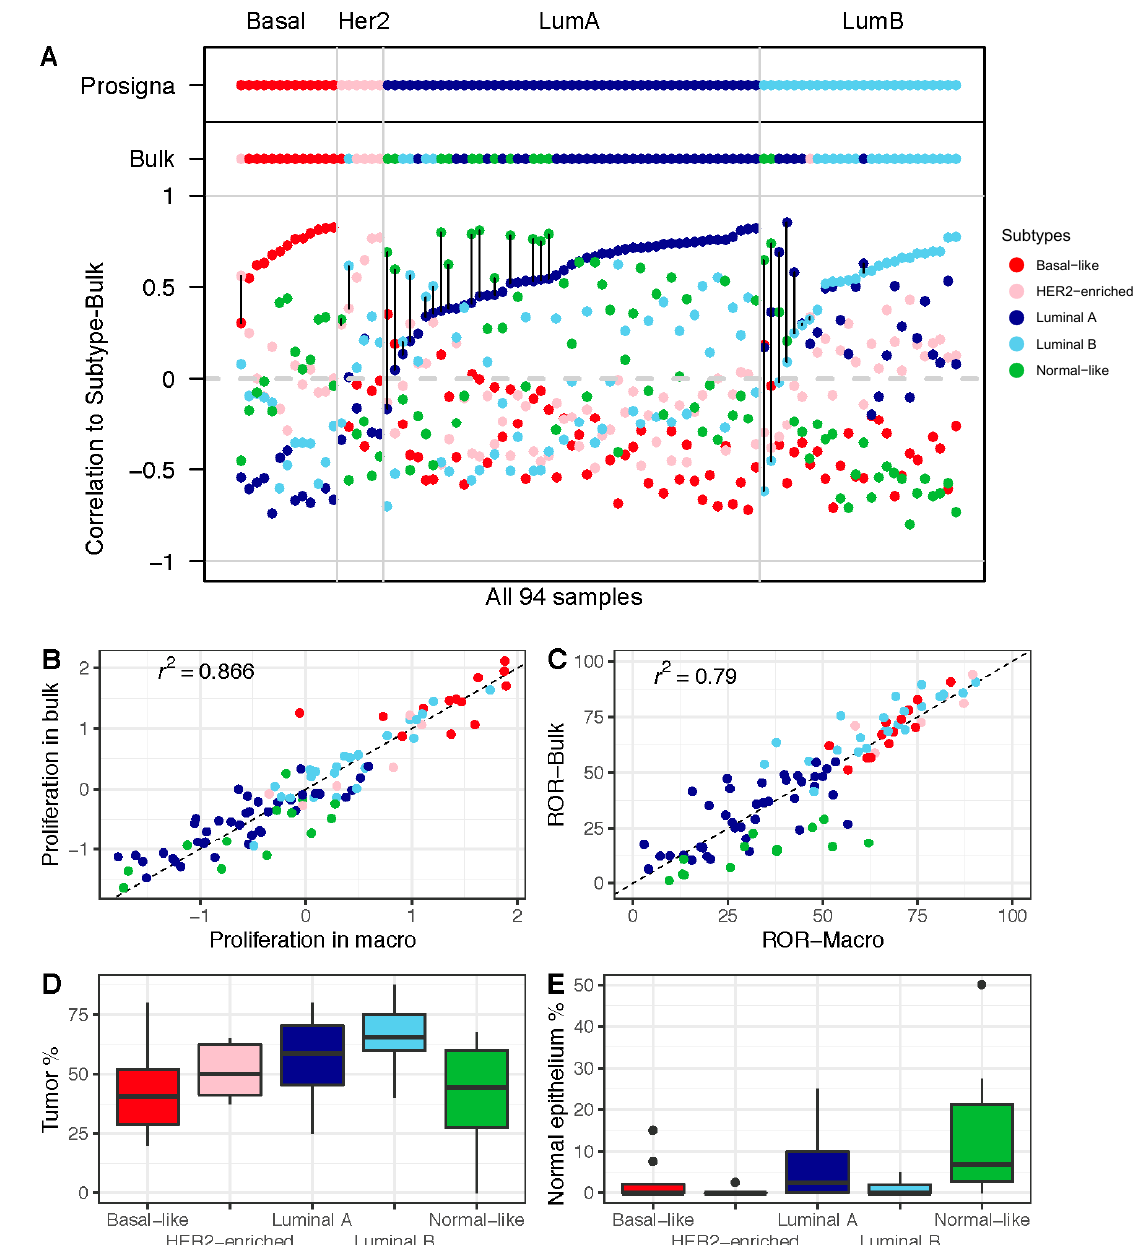
Figure 3. Impact of gene expression in FF bulk tumor tissue on subtype calls and ROR: ( A ) Correlation with each of the five PAM50 subtype centroids, calculated based on the research-based Subtype-Bulk from FF tumor tissue. PAM50 calls from Subtype-Prosigna and Subtype-Bulk are shown on top for comparison. Correlation coefficients on the y -axis, and the 94 breast tumor samples along the x -axis, are sorted by increasing correlation with Subtype-Prosigna. Discordant cases between Subtype-Prosigna and Subtype-Bulk are marked with black vertical lines. Samples are colored according to subtype (red = basal-like; pink = HER2-enriched; dark blue = luminal A; light blue = luminal B; green = normal-like). ( B ) Proliferation score from macrodissected FFPE plotted against FF bulk tumor tissue. ( C ) ROR-Macro plotted against ROR-Bulk. ( D ) Boxplots showing estimated tumor content across subtypes. ( E ) Boxplots showing estimated normal breast epithelium across subtypes. In panels ( B – E ), all 94 samples are color-coded by subtype according to Subtype-Bulk.